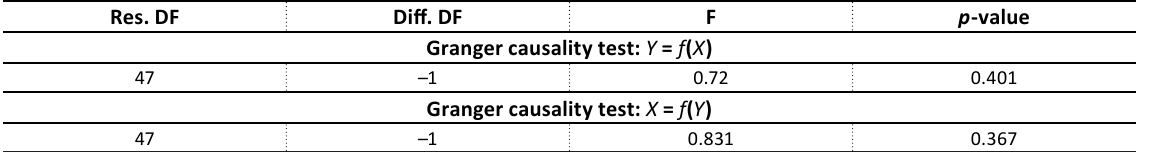
Table E4. Granger causality test: rank ( X ) and NGCESG ( Y ) Res. DF Diff.